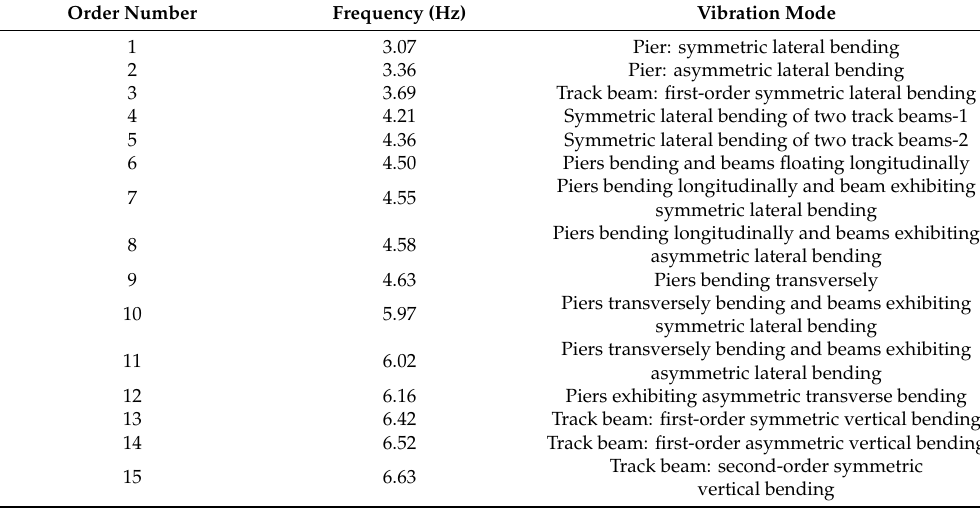
Table 3. Frequencies and vibration modes of the bridge.